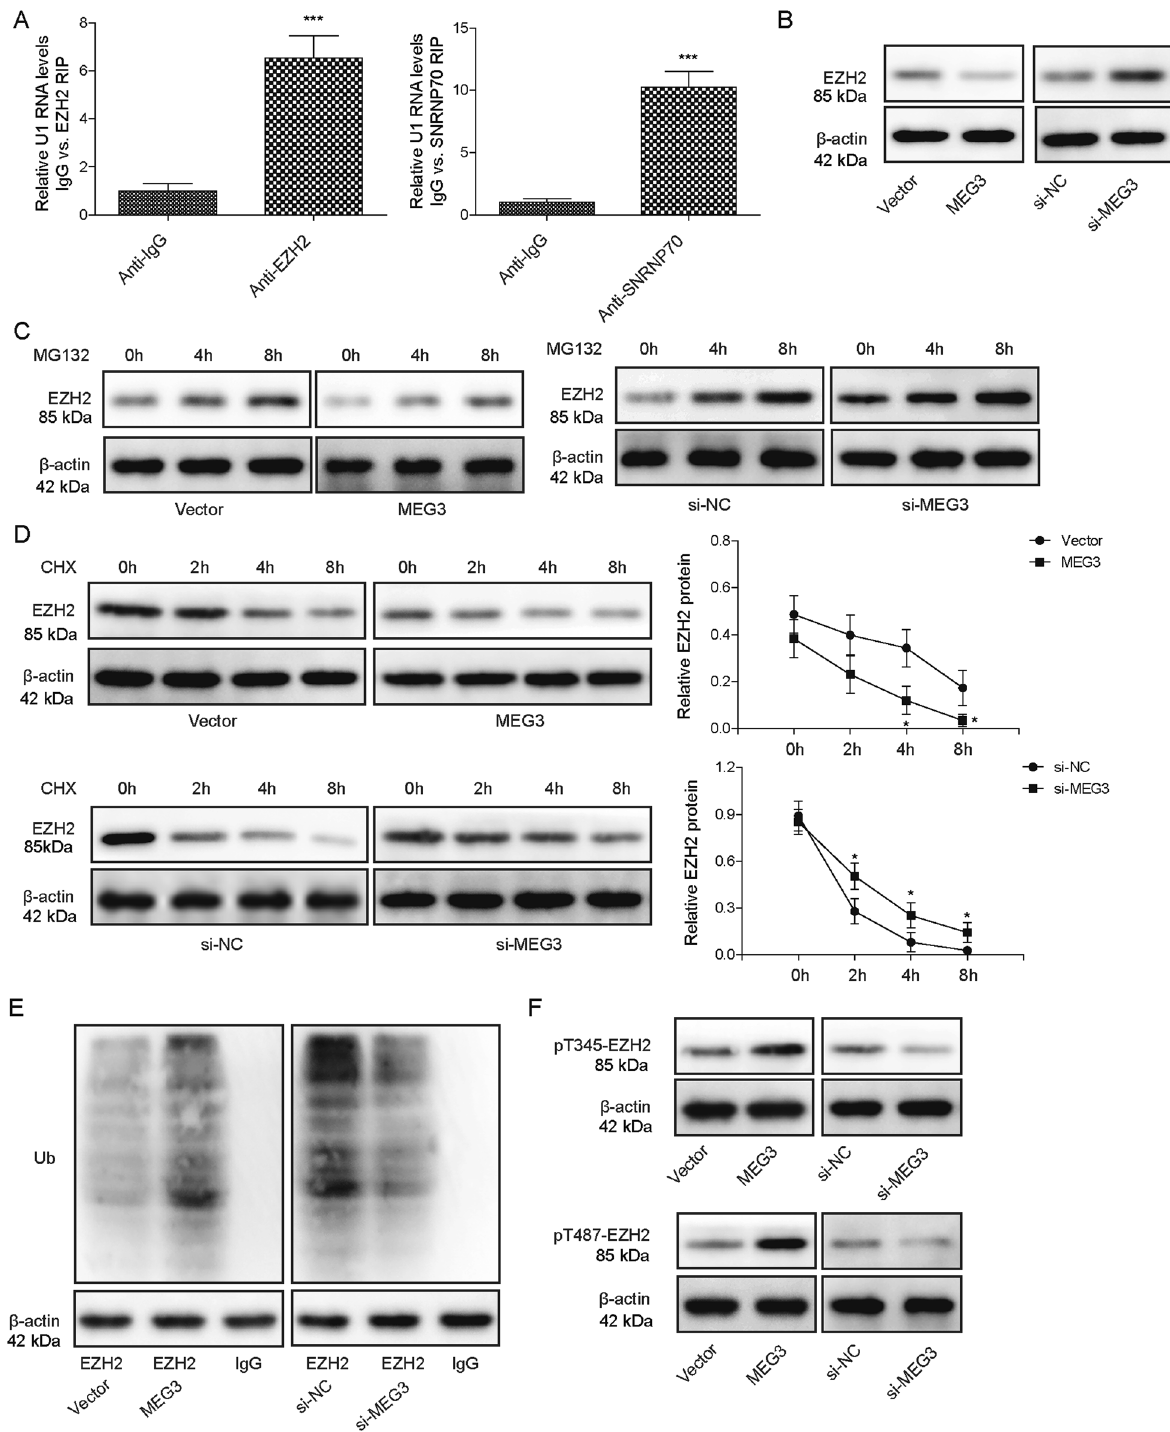
Fig. 3 MEG3 targeted EZH2 to ubiquitination-mediated degradation. A EZH2 expression was examined by Western blot in MEG3- expressing vs. vector and in si-MEG3-transfected vs. si-NC-transfected hepatocytes. B Interaction between MEG3 and EZH2 was examined by RIP assay. IgG was used as the negative control. C Indicated hepatocytes were treated with MG132 for 0, 4, and 8 h, respectively. EZH2 level was detected by Western blot. D Indicated hepatocytes were treated with cycloheximide for 0, 2, 4, and 8 h, respectively. EZH2 level was detected by Western blot. E Ubiquitinated EZH2 was detected by co-immunoprecipitation using either anti-EZH2 or IgG. F The levels of phosphorylated EZH2 at T345 and T487 were examined by Western blot in indicated hepatocytes. * P < 0.05, *** P < 0.001.